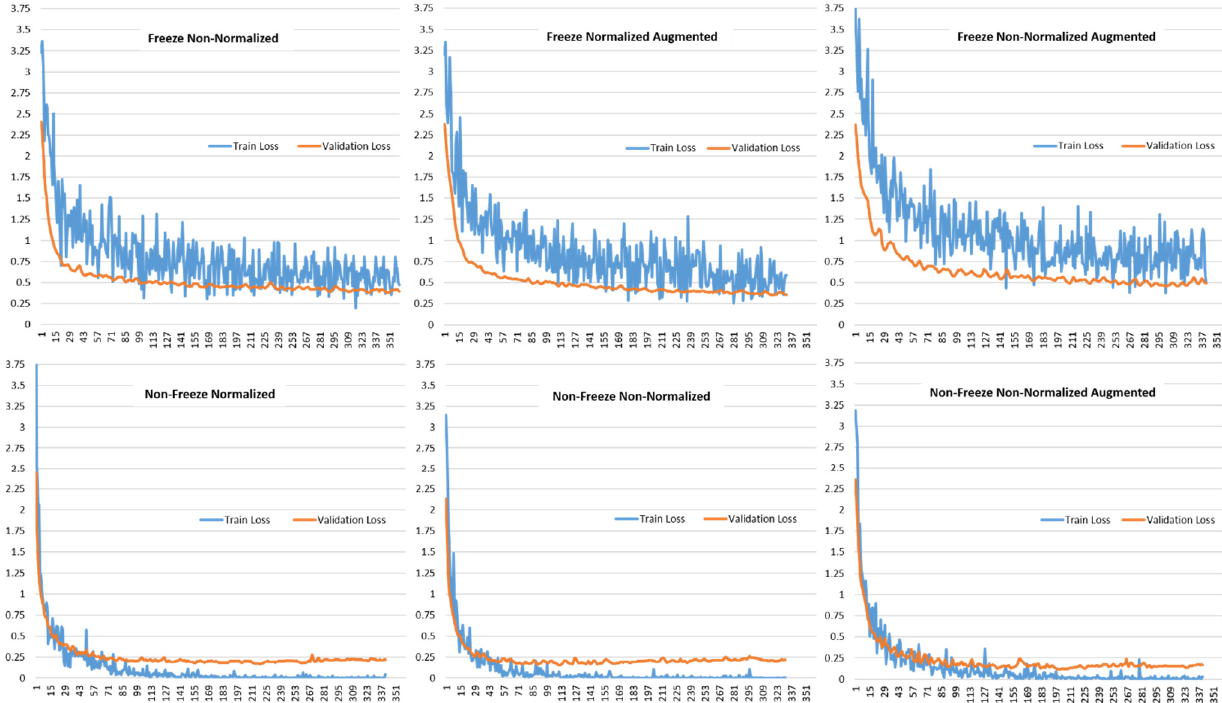
Figure 6. Comparison of Train Loss and Validation Loss for different model setups for VGG19-based Transfer Learning.